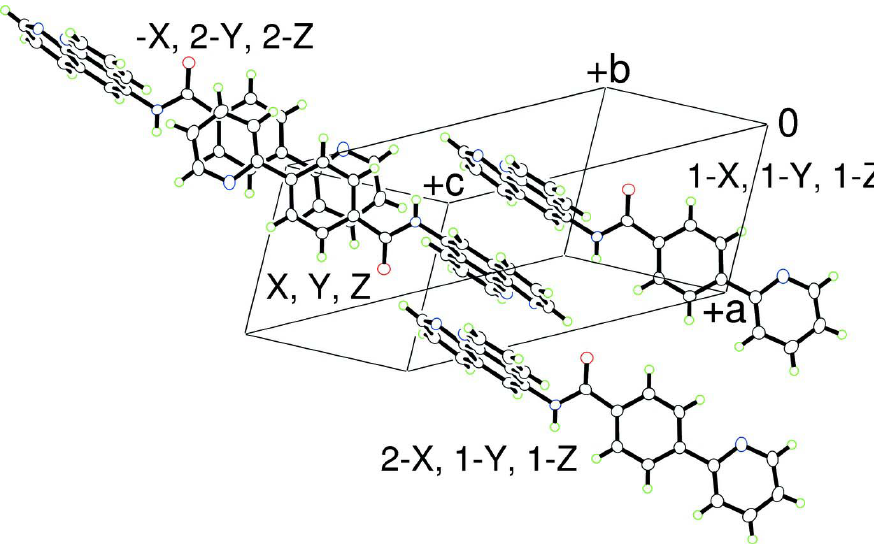
Figure 2 A view showing the manner how the aromatic moieties are stacked in the crystal. Water molecules are omitted for clarity.